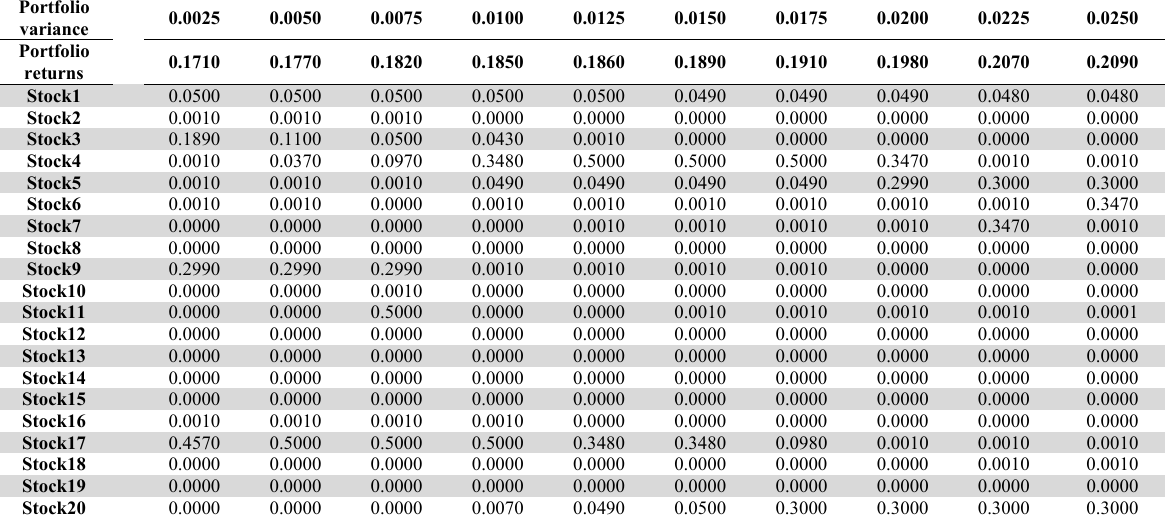
The optimal answer based on Markowitz Model